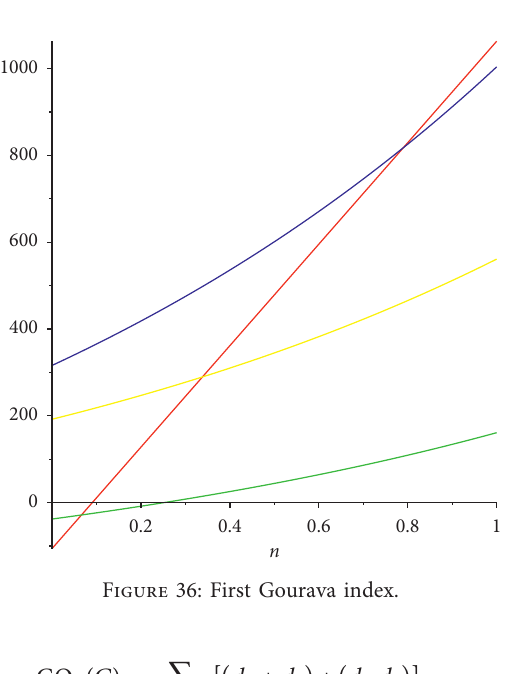
Figure 36: First Gourava index.